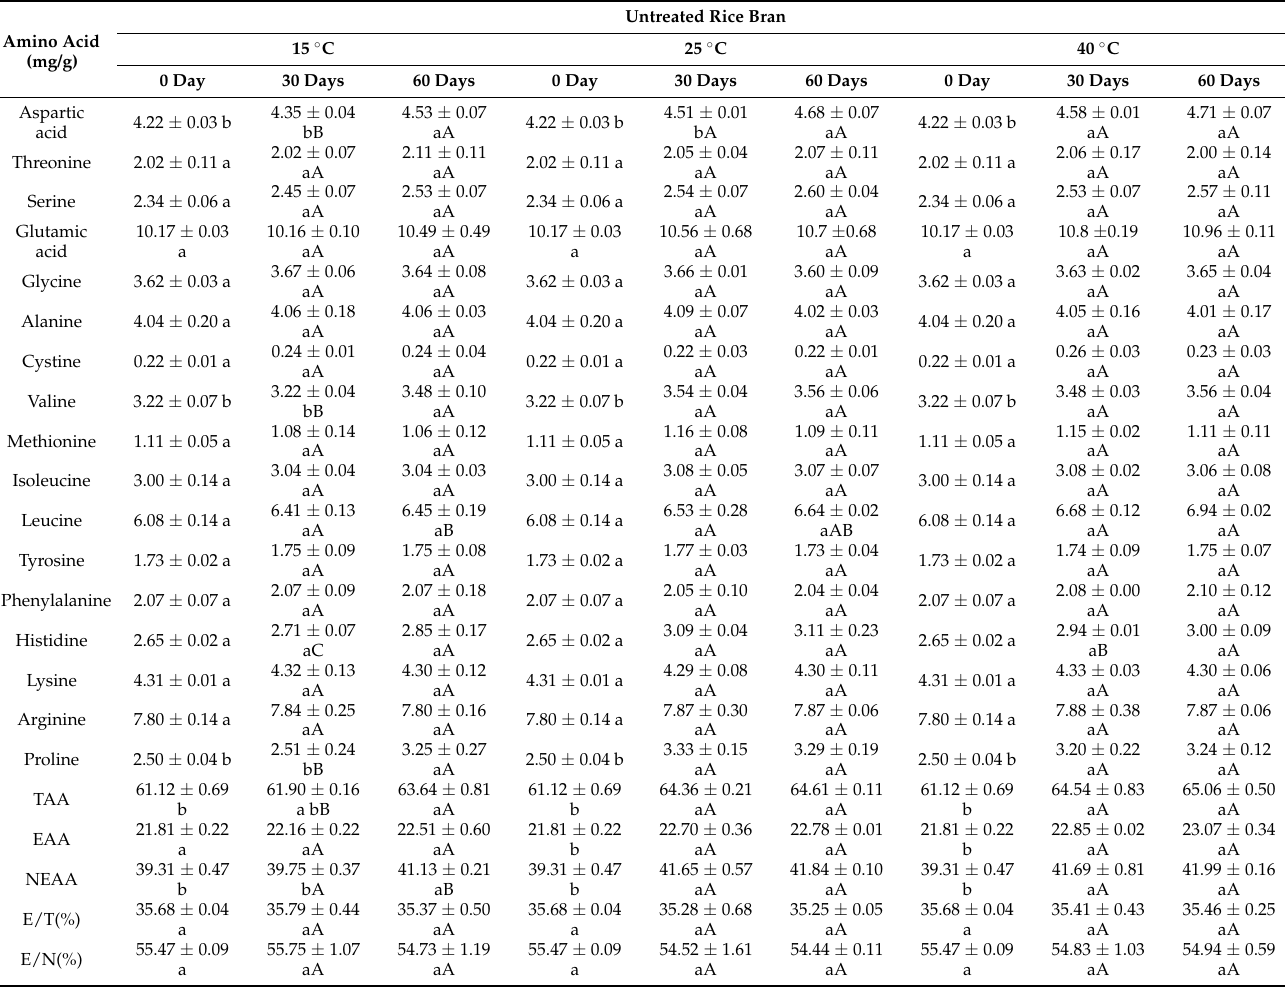
Table 5. Amino acid composition and content changes in untreated rice bran during